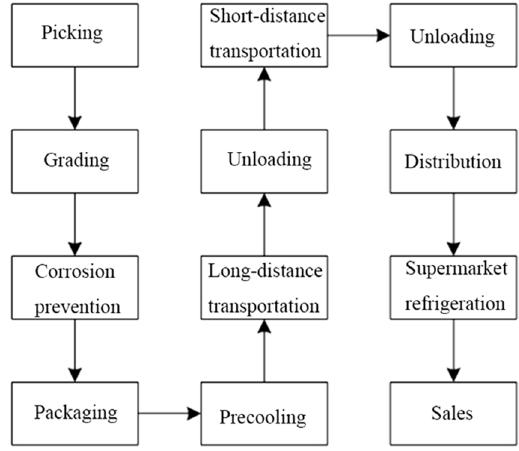
Fig. 2. The cross-regional mangosteen cold chain logistics network.